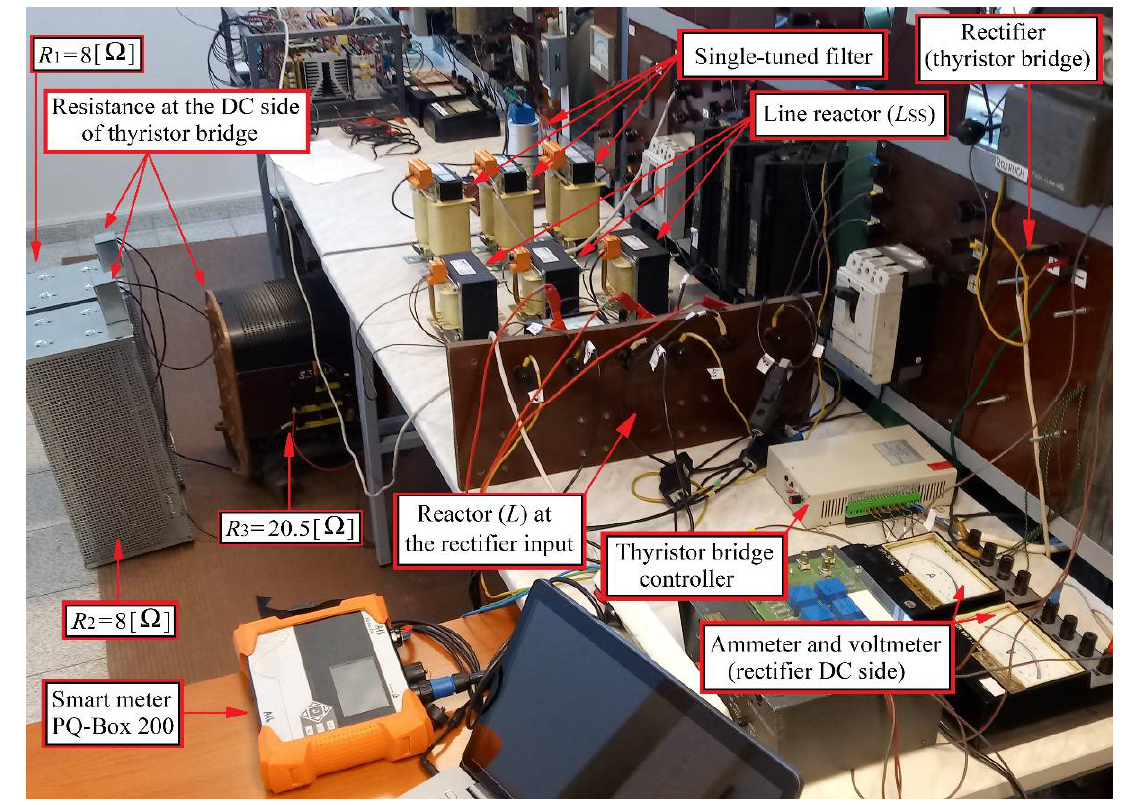
Figure 44. Laboratory setup with the single-tuned filter after the line reactor connection.